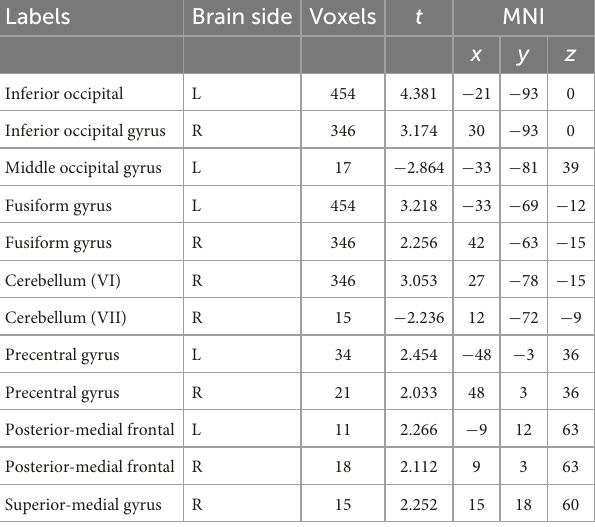
TABLE 2 Clusters of brain areas activated by circular